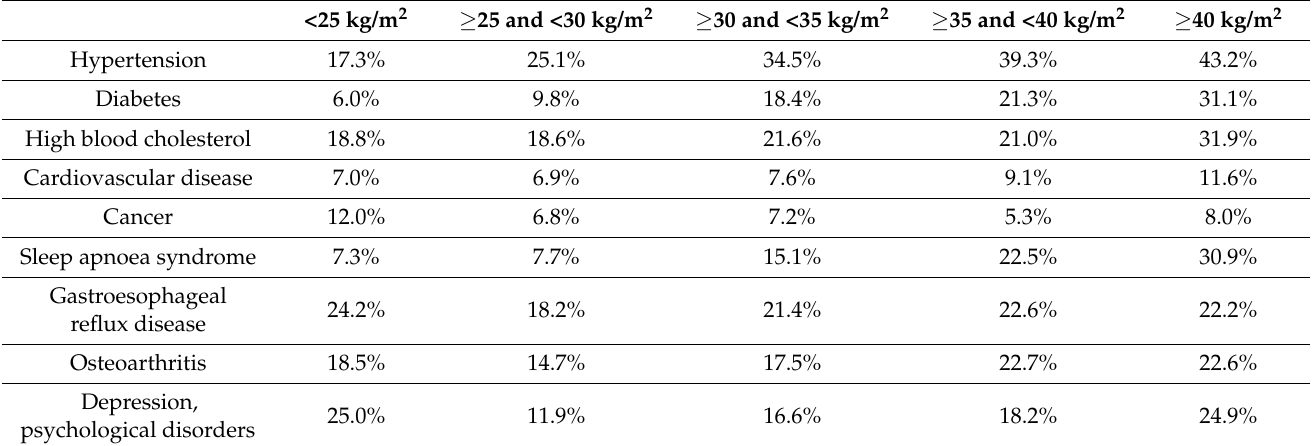
Table 1. Prevalence of specific past or current morbidities by BMI category, LCO 2020 Obepi-Roche